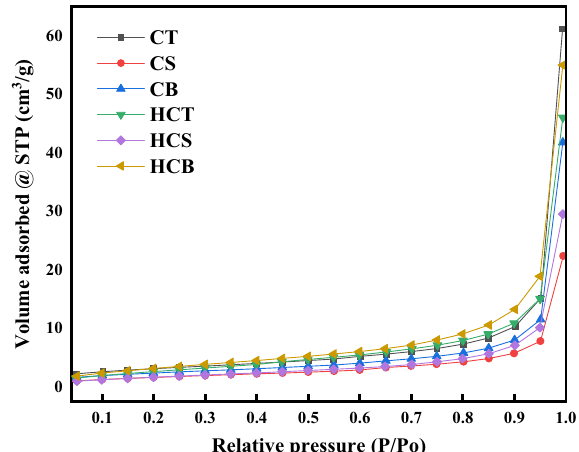
Figure 14. Isothermal adsorption plots of and Co-HTC hydrochar.